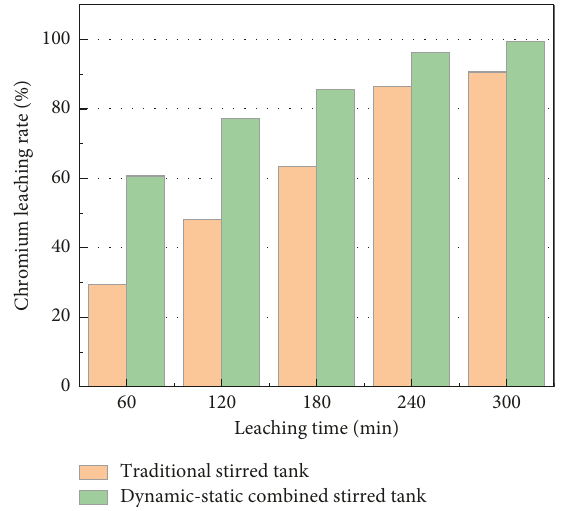
Figure 15: The chromium-leaching rate under the two stirred tanks varied with the reaction